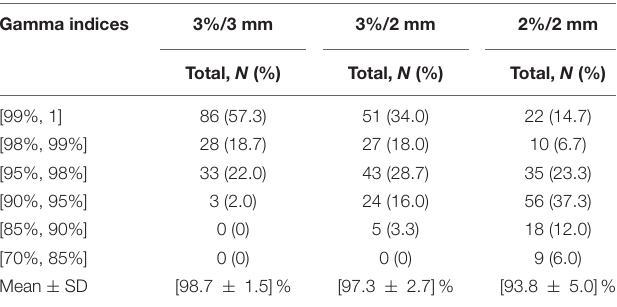
TABLE 2 | The summary information of different gamma